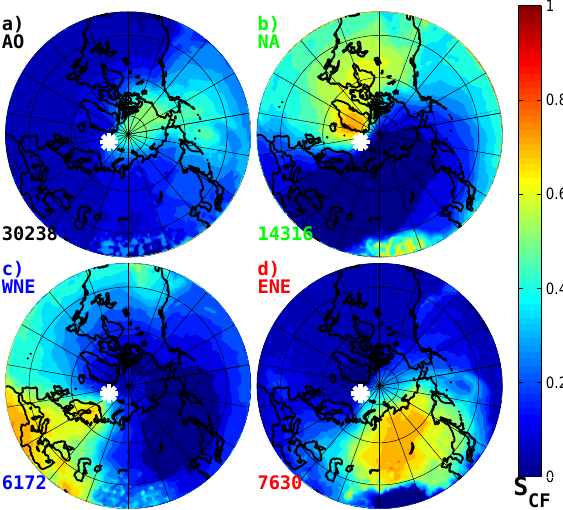
Fig. 7. Annual normalized emission sensitivity S CF for clusters (a) AO, (b) NA, (c) NE and (d) PA for Alert 1985–2008 (see Eq. 4). The number of cluster members is reported in the bottom left cor- ner of each panel. The location of the Alert station is marked by a white asterisk. AO, Arctic Ocean cluster; NA, North American cluster; NE, Northern Eurasian cluster; and PA, Pacific and South- East Asian cluster.